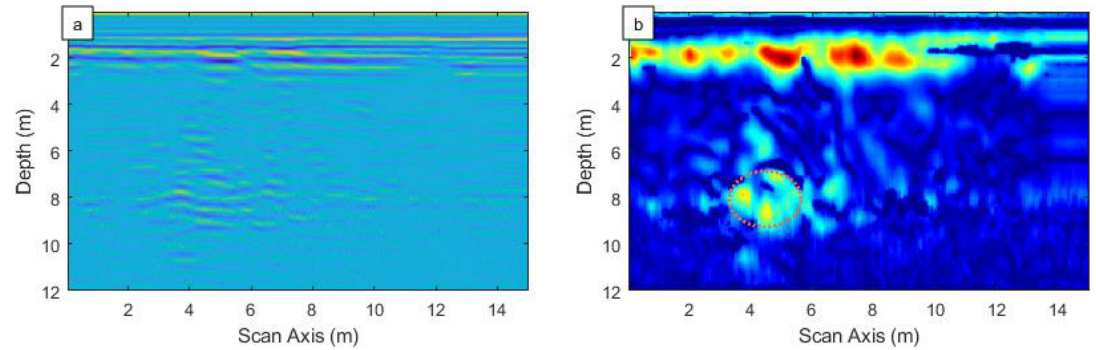
Figure 14. Real world GPR data and frequency spectrum: ( a ) time domain GPR record data; and, ( b ) frequency division section at 80 kHz.